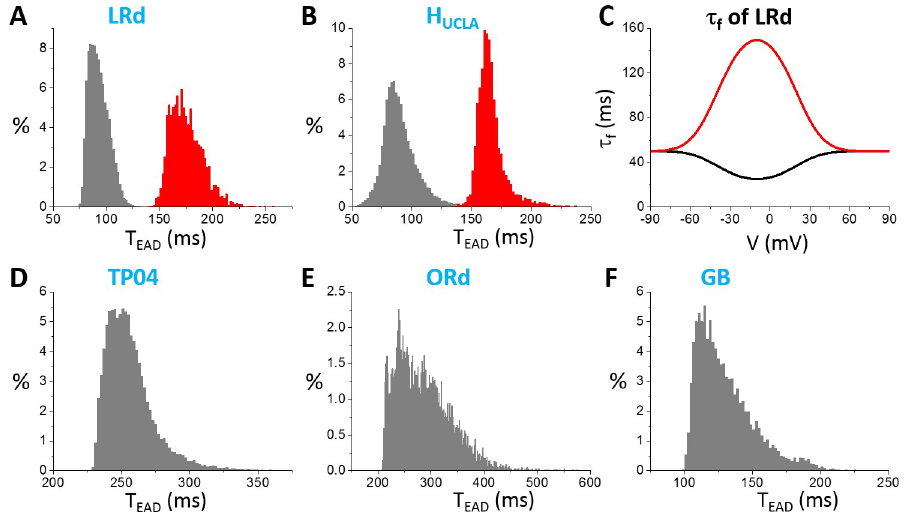
Fig 8. Distributions of T EAD in different models. A . LRd. B . H UCLA . D . TP04. E . ORd. F . GB. In these distributions, the ionic conductance (see SI for the specific ones for each model) were randomly drawn from the assigned intervals. C . τ f versus V in the original LRd (black) and the modified one (red). The same τ f was used in the H UCLA model as in the LRd model.